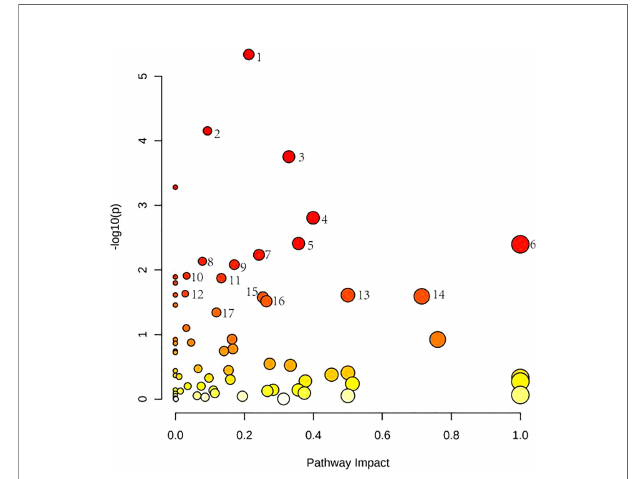
FIGURE 4 | Metabolomics reveals correlated differential metabolic pathways between normal, OA, and OP-OA. Metaboanalyst (http://www.Metabo- analyst.ca/) carried out metabolic pathway enrichment analysis, with P<0.05; 17 related metabolic pathways were